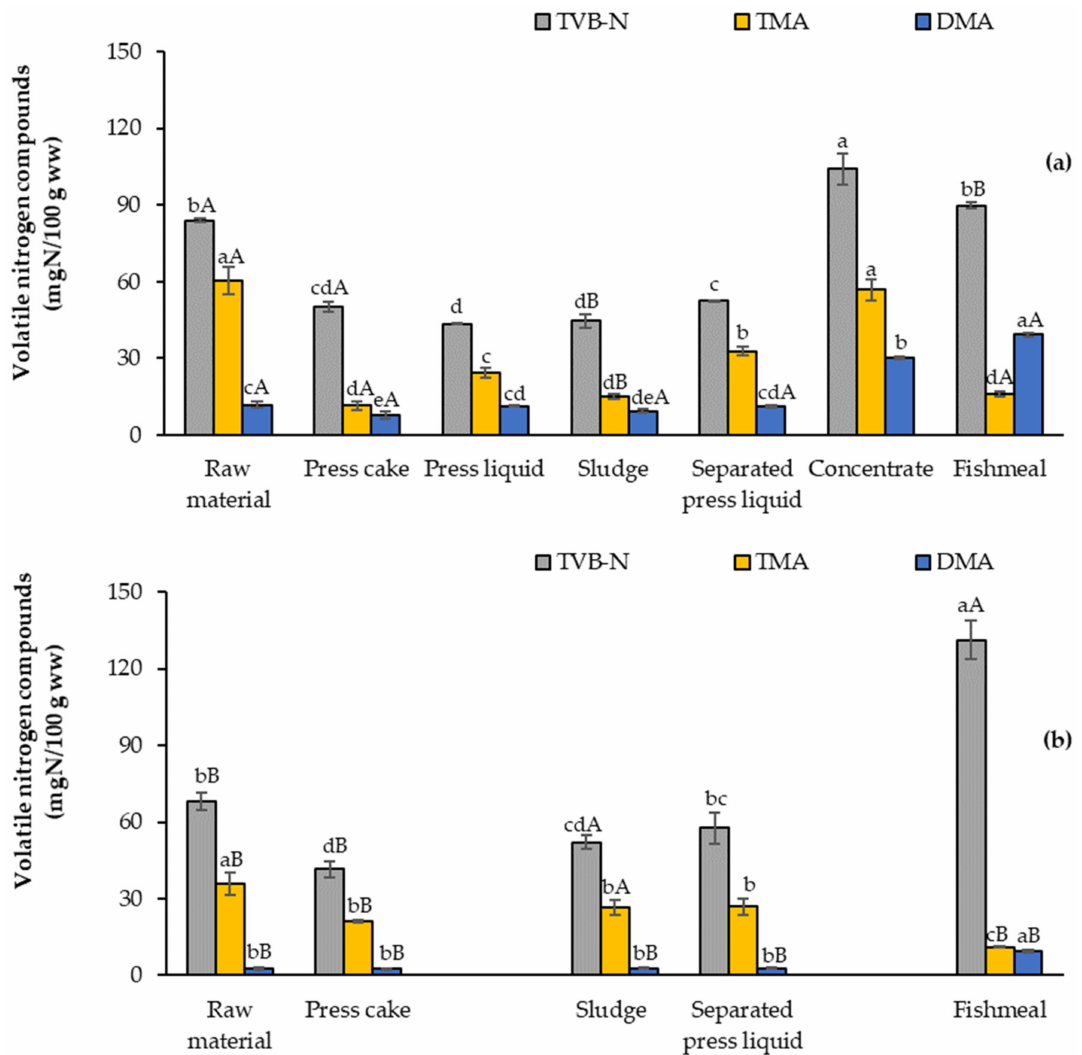
Figure 5. Volatile nitrogen content (mg N/100 g ww) in streams from the industrial BW fishmeal production ( a ) and MHB fishmeal production ( b ). Within each parameter, lowercase letters investigate significant differences between sampling locations, uppercase letters show significant differences between raw materials at the sample processing step. Statistical significance levels were set to p < 0.05 for all